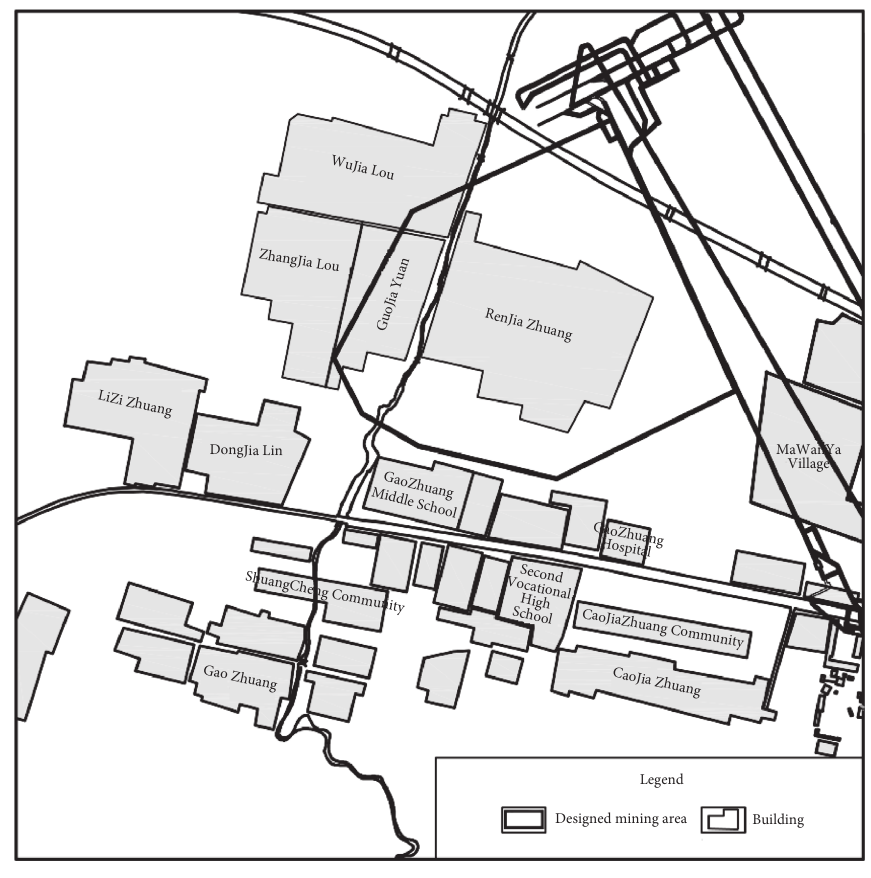
Figure 8: Ground and underground contrast